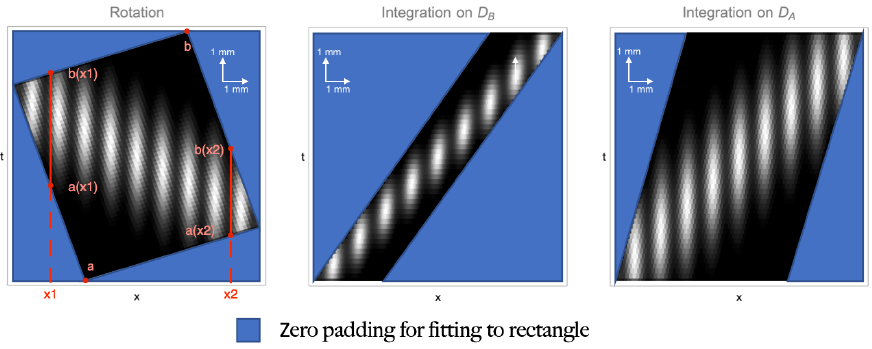
Figure 2. Three possible refocusing transformations applied to the correlation function of Figure